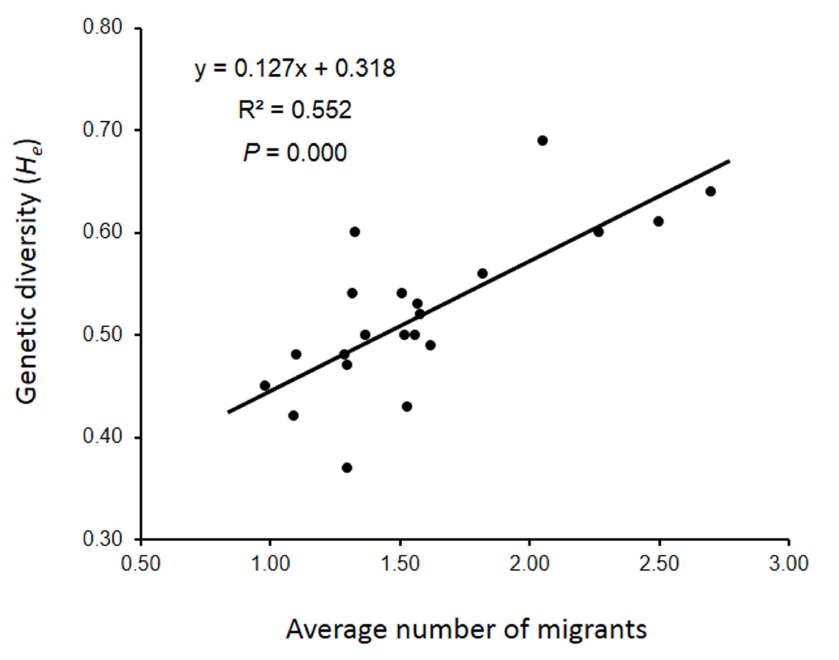
Figure 3. Correlation between genetic diversity and the average number of immigrants of a particular weedy rice population. Nei’s (1987) unbiased expected heterozygosity ( H e ) [22] was used to estimate the